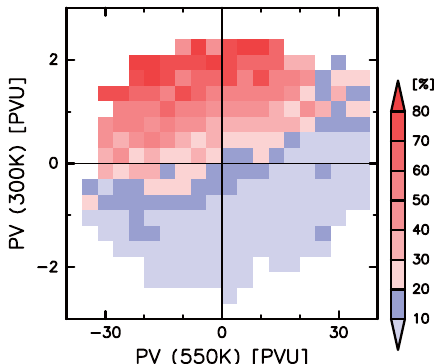
Fig. 6. Probability of the simultaneous occurrence of PSCs at 15– 25km and UCs at 9–11km at 70–75 ◦ S as a function of PV anoma- lies from the zonal mean at the 550K and 300K isentropic sur- faces. The size for each bin is 4PVU × 0.3PVU. Time period is June through September from 2007 to